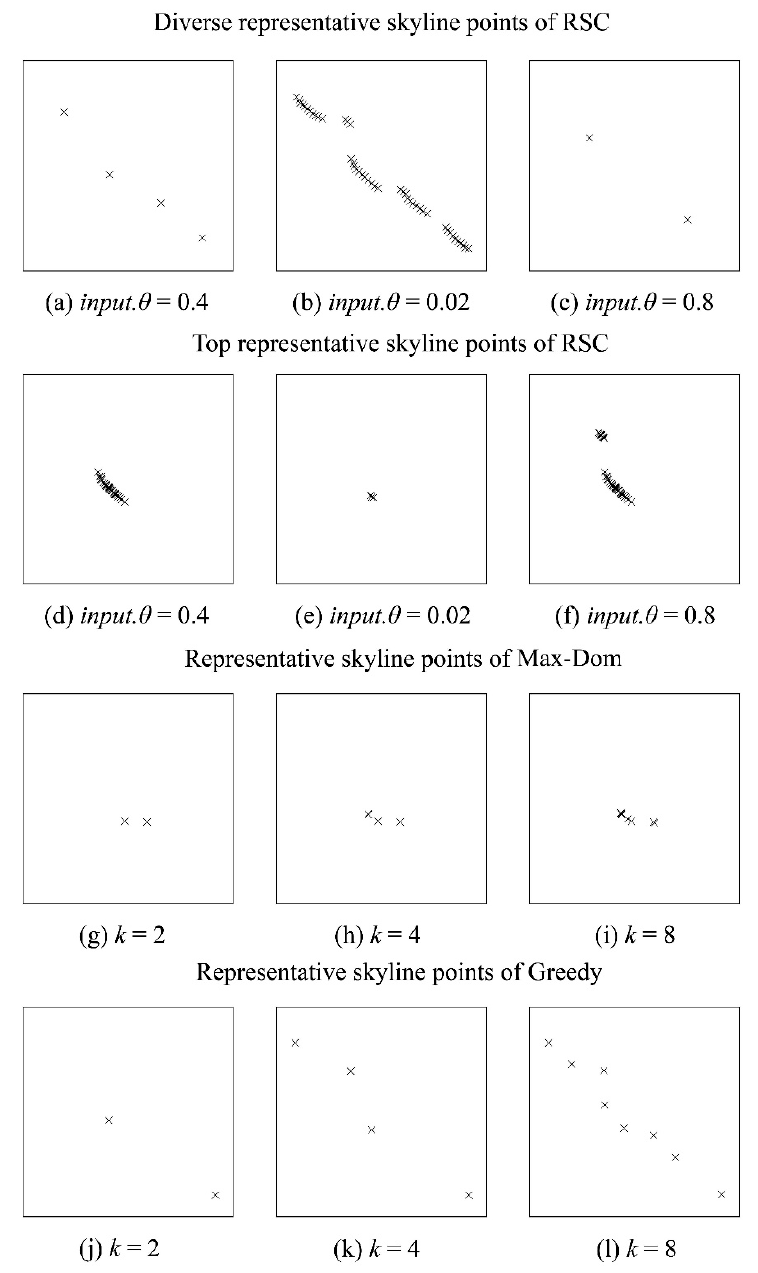
Figure 9. Representative skyline points of Anisotropic dataset.